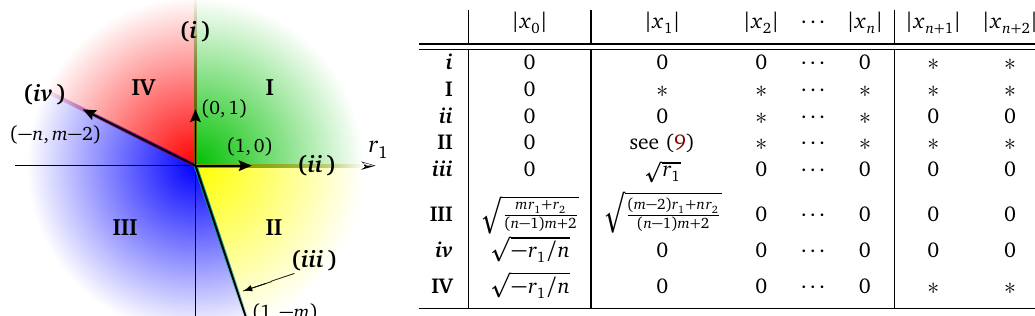
“geometric” phase; m